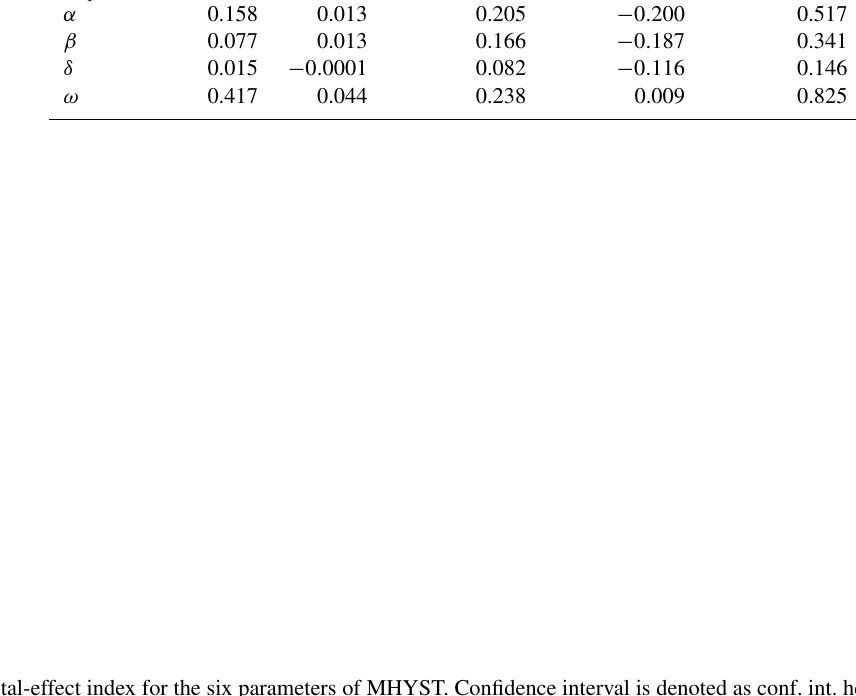
Table A2. Sobol total-effect index for the six parameters of MHYST. Confidence interval is denoted as conf. int. here.